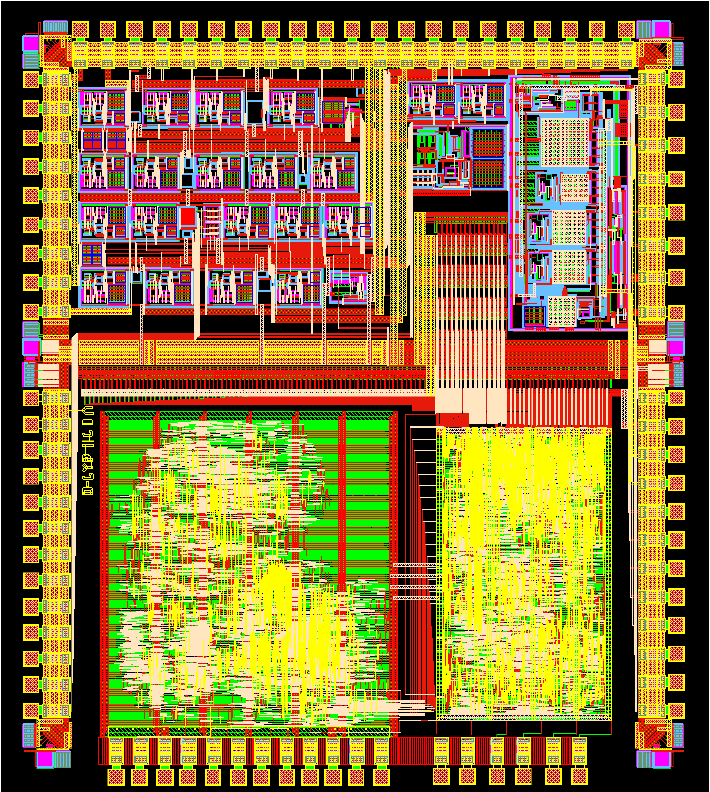
Figure 5. Chip layout of silicon gyroscope interface circuit.